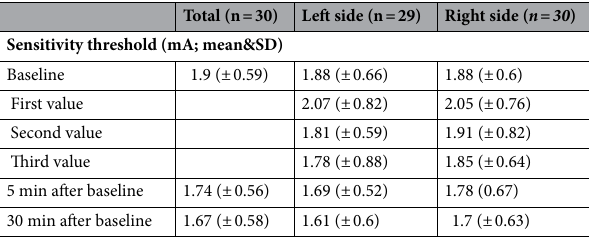
Table 1. Results of the sensitivity threshold